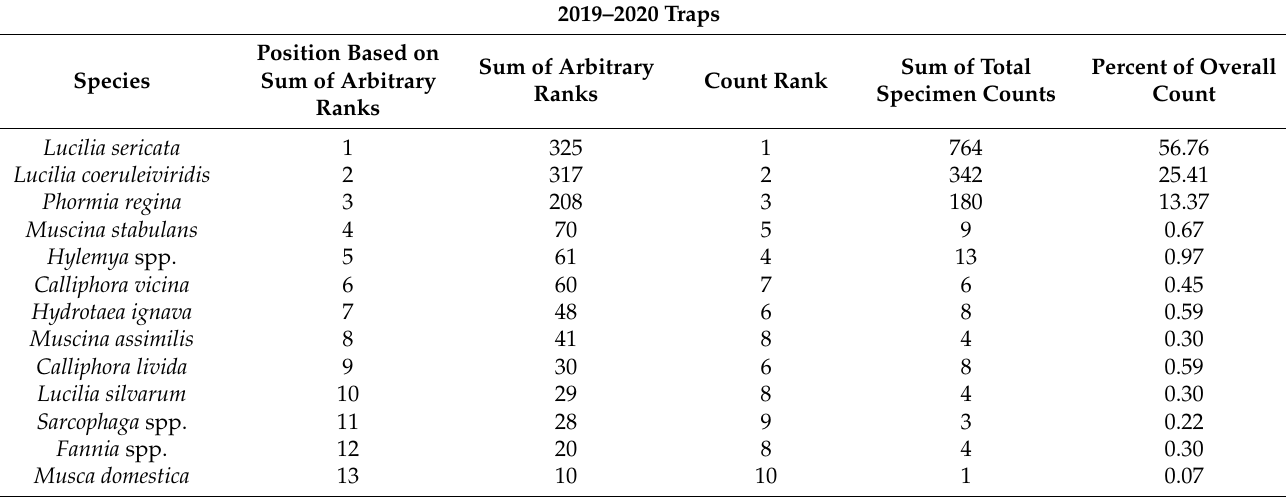
Table 1. Fly species trapped in the current 2019–2020